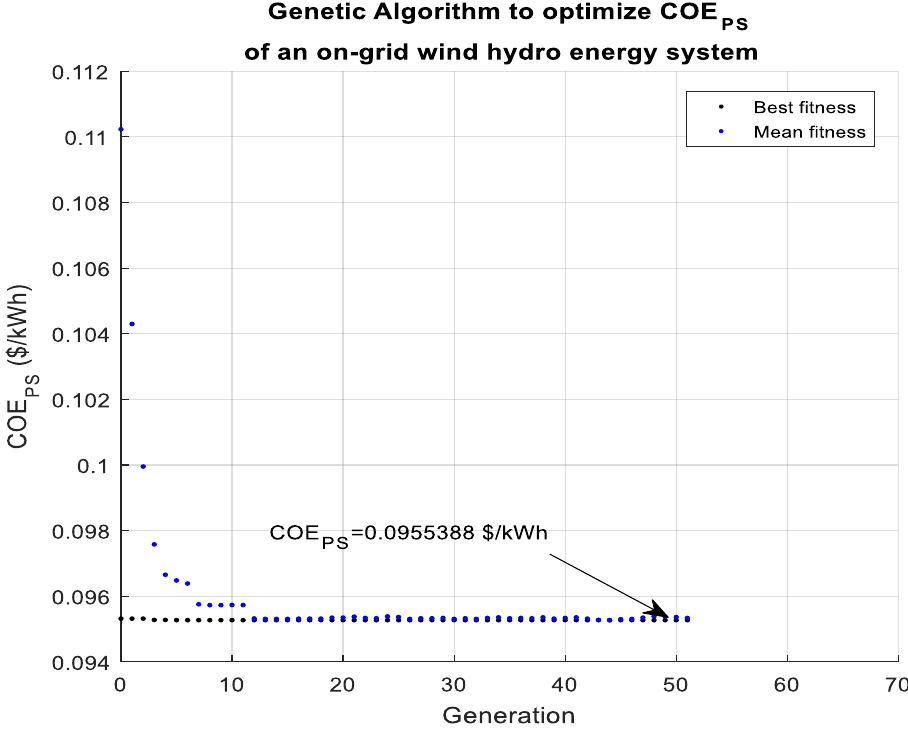
Figure 6. GA to optimize COE PS .